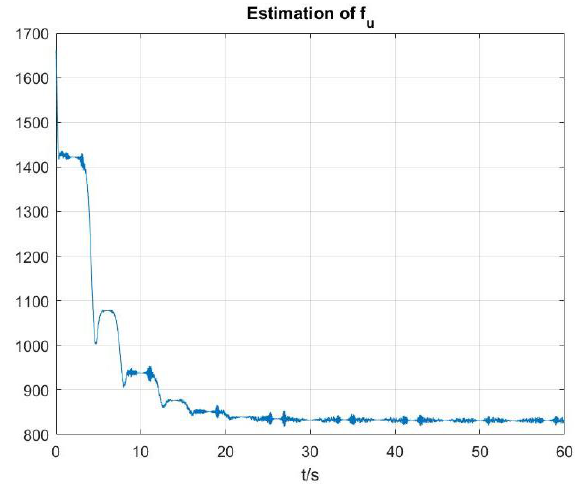
Figure 3. Evolution of the scaled focal length f u